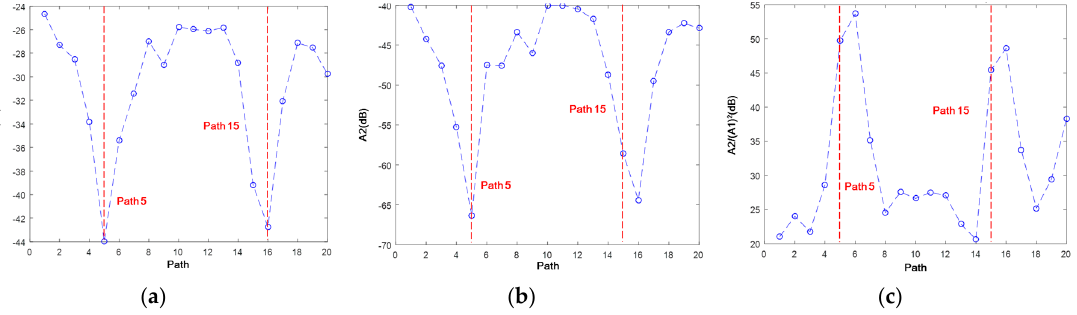
Figure 16. Magnitudes of the mode pair S 1 -S 2 (3.42–6.84 MHz mm) extracted through STFT on the twenty paths in the experiment in ( a ) fundamental mode A1; ( b ) second harmonic mode A2; and ( c ) A2/(A1) 2 .